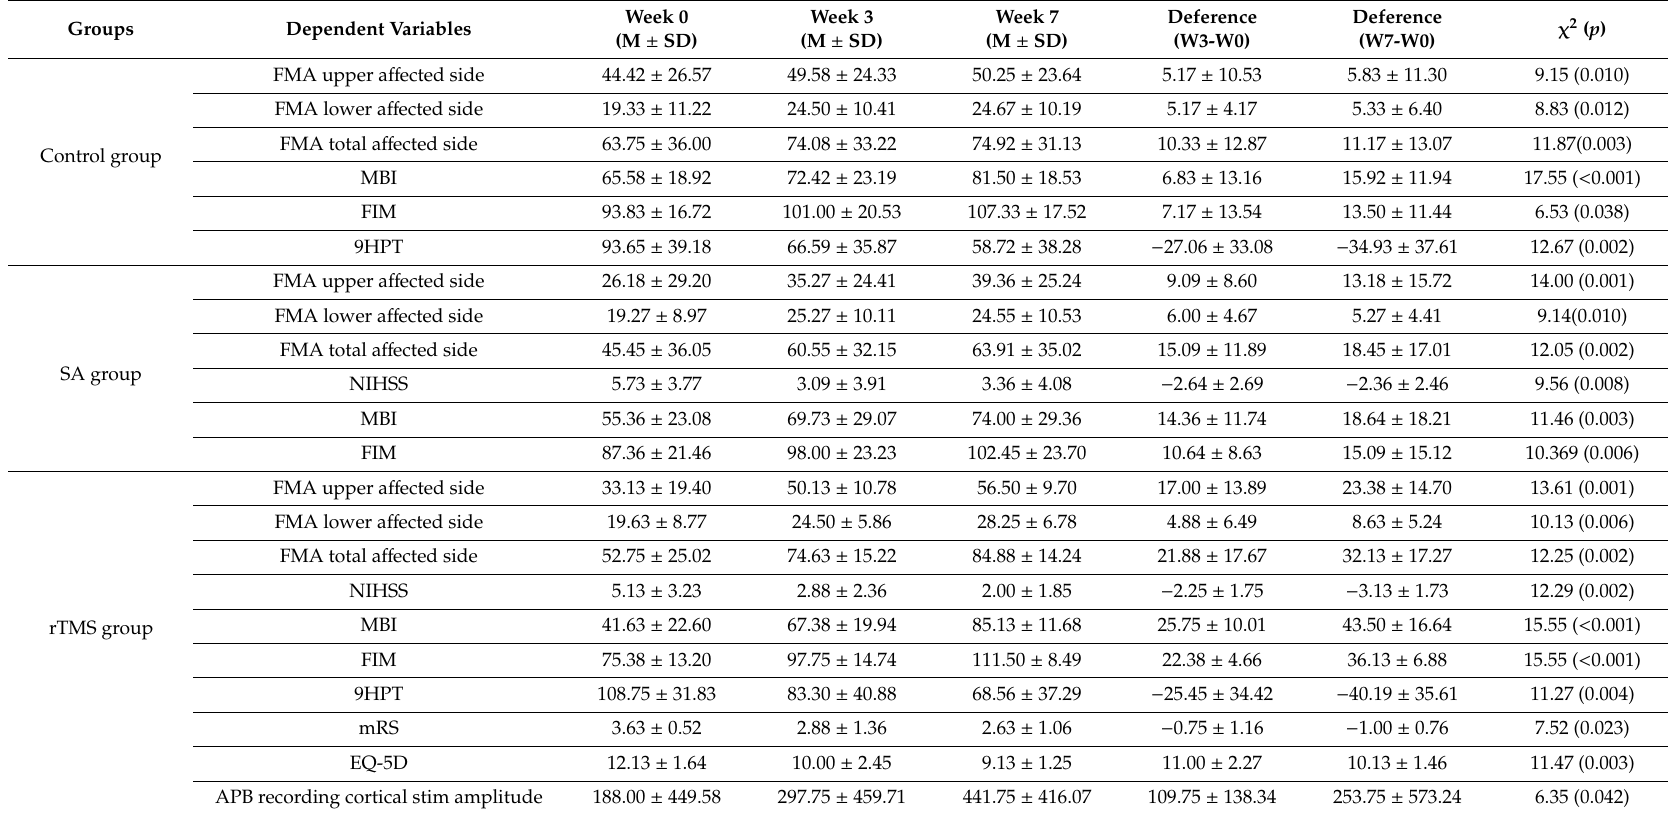
Table 3. Significant changes in outcome measures after treatment completion in the four